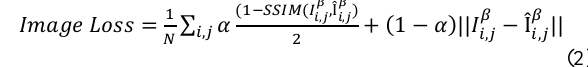
Figure 5. MonoGAN for stereo depth estimation. Adapted